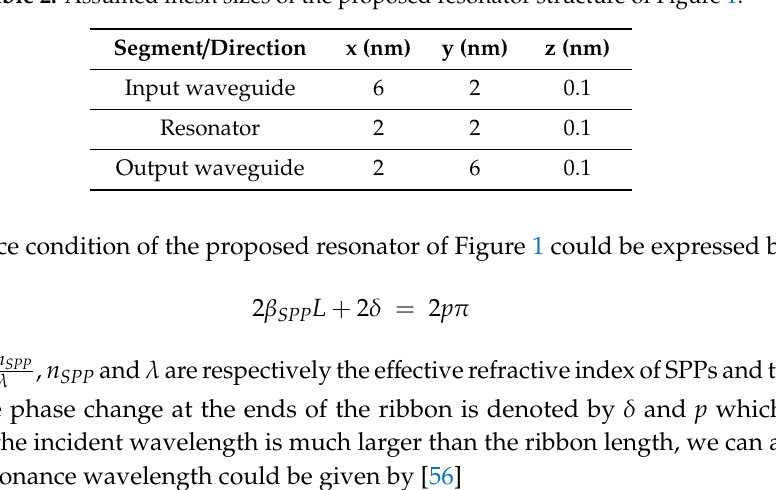
Table 2. Assumed mesh sizes of the proposed resonator structure of Figure